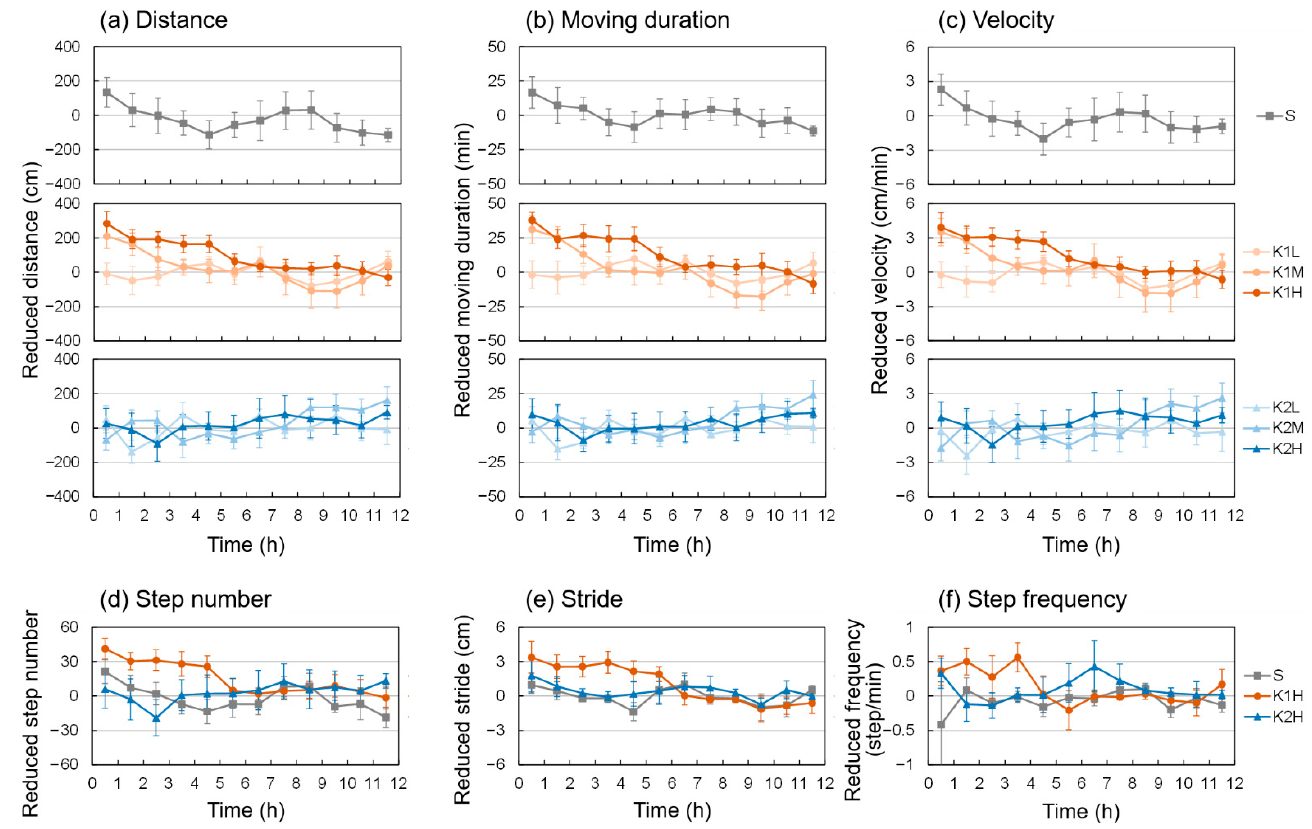
Figure 2. Trend of locomotor behavior of A. japonicus within 12 h after injection compared with before injection: ( a ) distance; ( b ) moving duration; ( c ) velocity; ( d ) step number; ( e ) stride length; ( f ) step frequency. Behavioral data were measured hourly, and the values in the figure are the differences ( Δ Y) at the same moment in the two adjacent days before and after injection. The error bars in the figure represent the standard error ( n = 8 for each group). S is the seawater control group, K1 and K2 are the neuropeptide treatment groups, and H/M/L represent high, medium, and low concentrations.